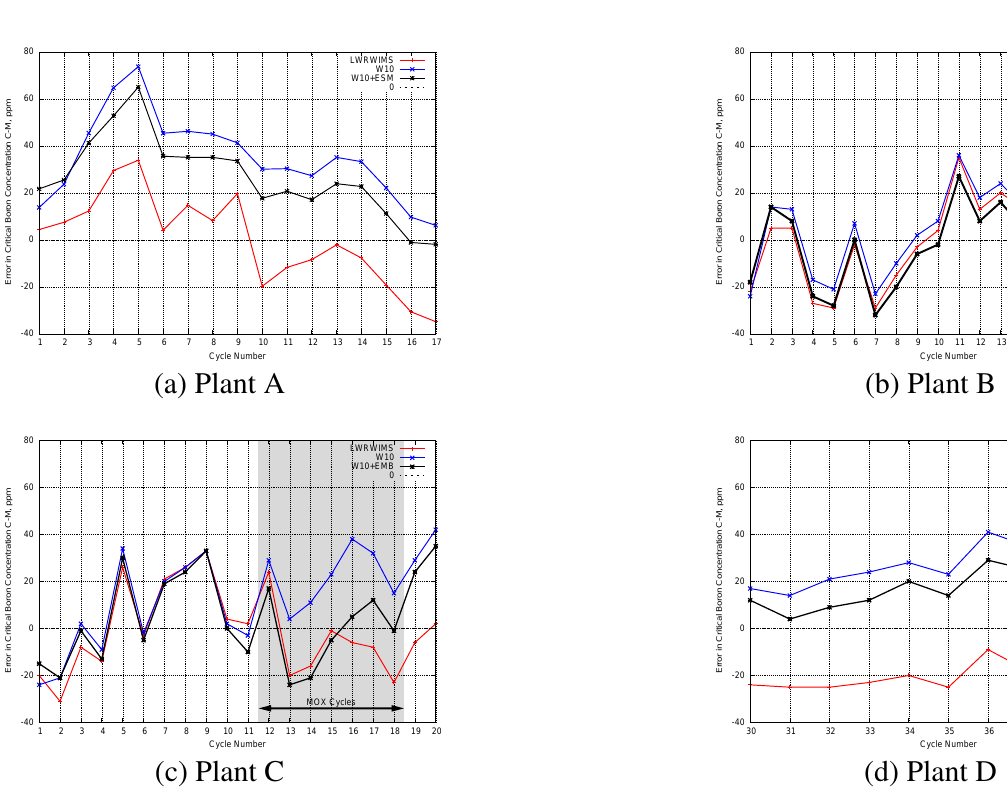
Figure 2: Critical Boron Concentrations at BOC, HZP